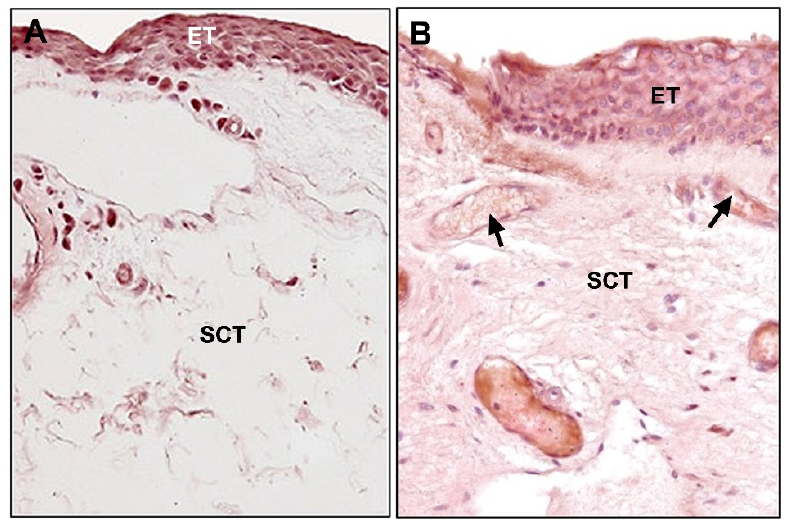
Figure 8. Photomicrographs show immunohistochemical staining for fibrillin-1: ( A ) Conjunctival tissue ( × 400); ( B ) pterygium ( × 400). Fibrillin-1 expression was increased in pathologic tissue. (ET, epithelial tissue; SCT, subepithelial connective tissue; → , blood vessels).